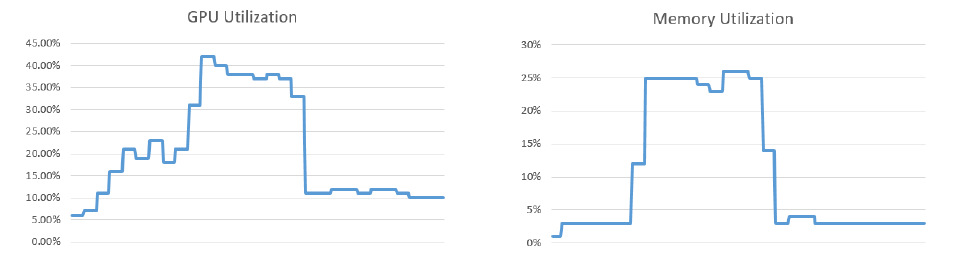
Figure 5. GPU utilization parameters during an